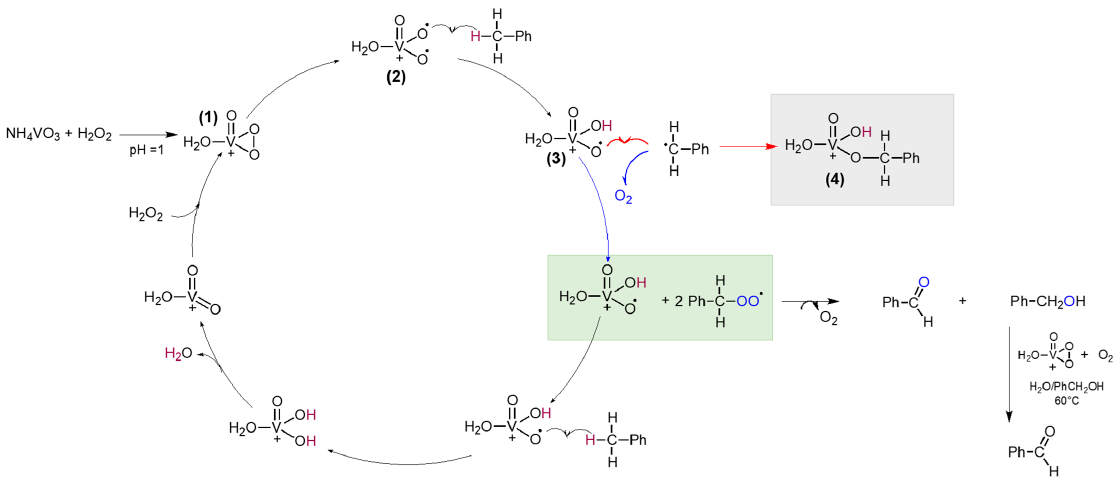
Figure 4. Proposed catalytic cycle for toluene oxidation to benzaldehyde.